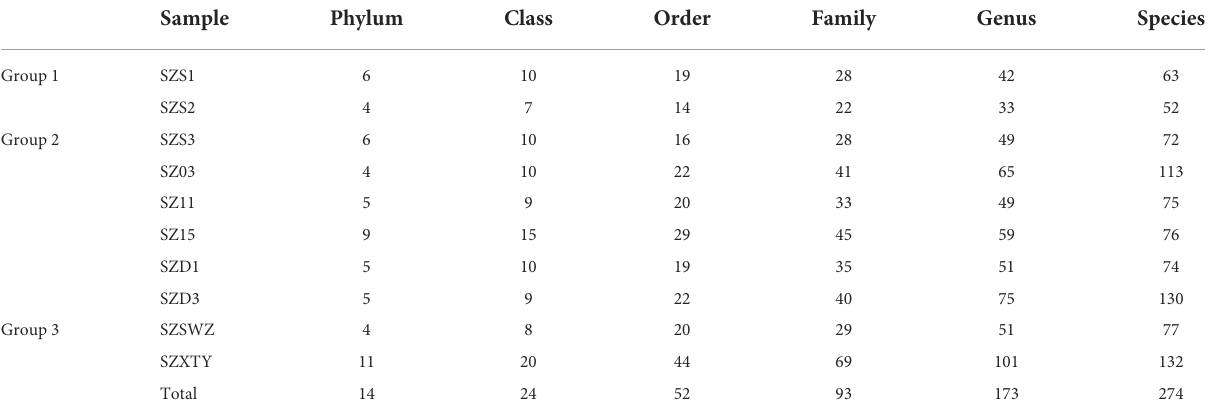
TABLE 1 Statistics of species